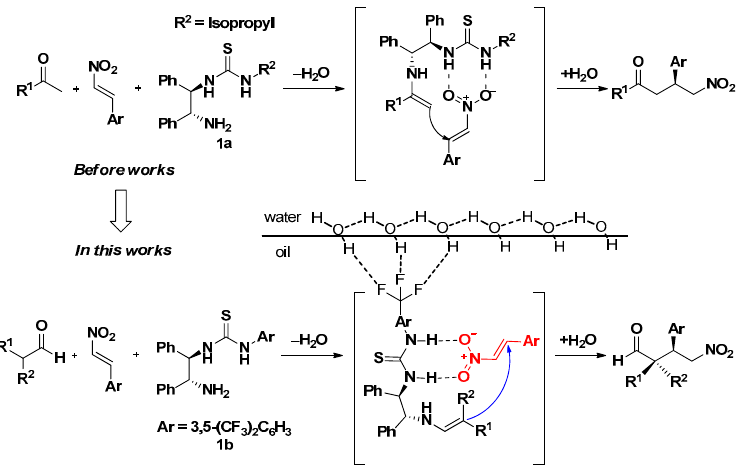
Figure 1. Mechanism of the Michael reaction of aldehydes and nitroalkenes using a thiourea-based catalyst.